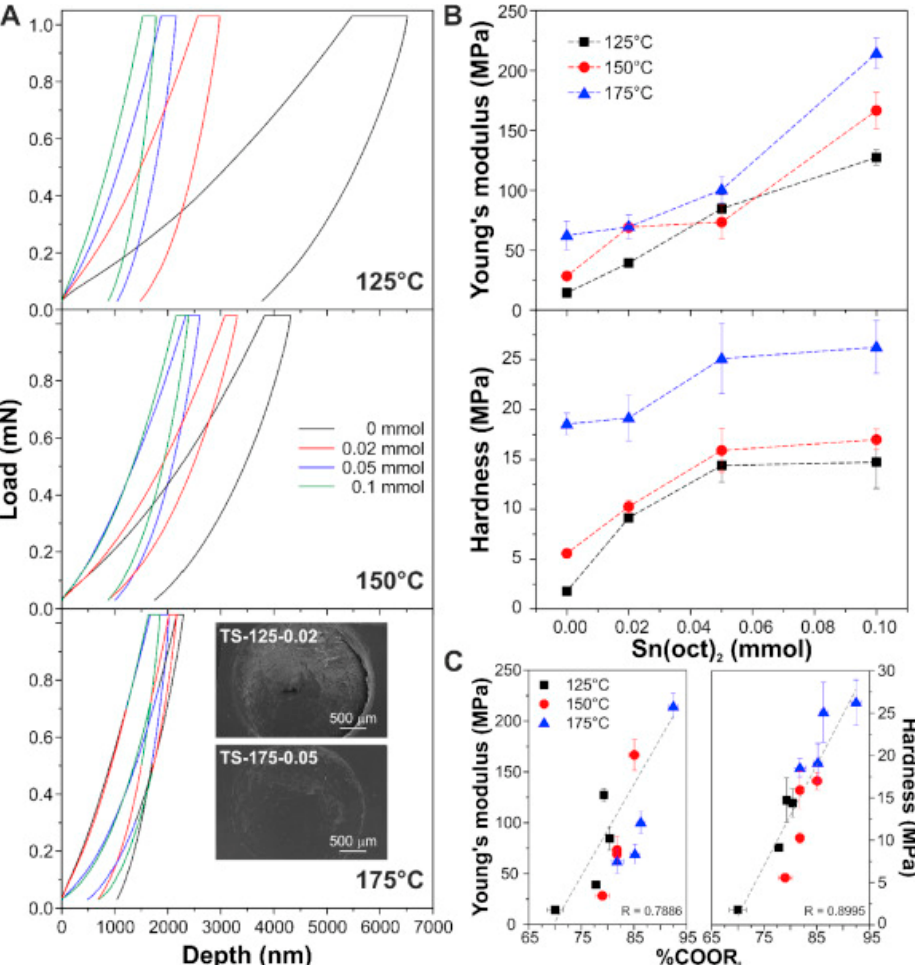
Figure 2. Mechanical behavior of biopolymers synthesized from tomato pomace [8]; ( A ) the load-depth indentation curves for biopolymers that were synthesized with different amounts of catalysts, for 7 h; ( B ) impact of catalyst amount on the Brinnell hardness and Young’s modulus; ( C ) shows the linear regression relationship between % ester in the polymer, Young’s Modulus and hardness. (Reproduced with permission from publisher).